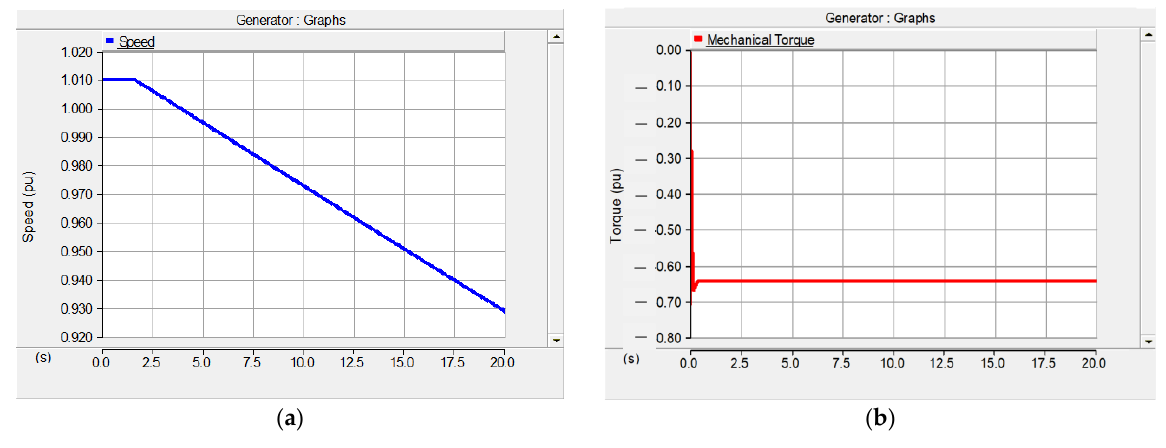
Figure 24. ( a ) Speed; ( b ) torque.